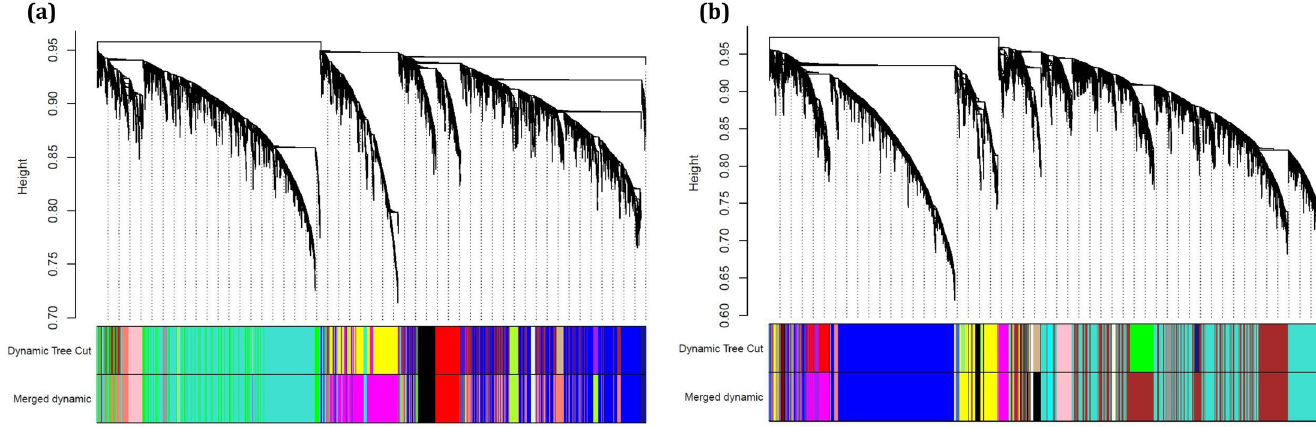
Fig 2. Dendrogram of clustered genes for (a) ATLL and (b) HAM/TSP based on a dissimilarity measure (1-TOM). The colors of rows represent the module membership resulted from the dynamic tree cut method and after merging modules.